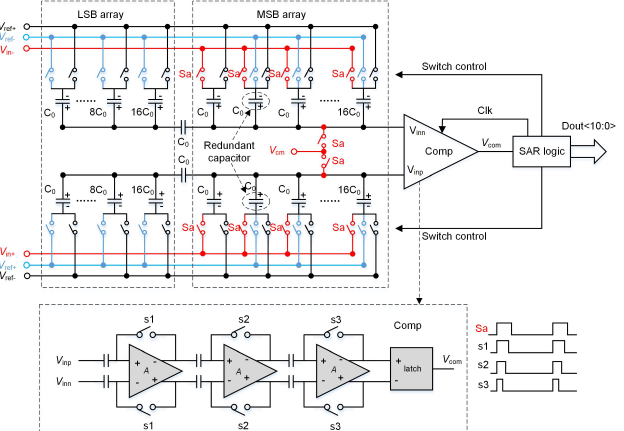
Figure 10. Schematic of the SAR ADC.